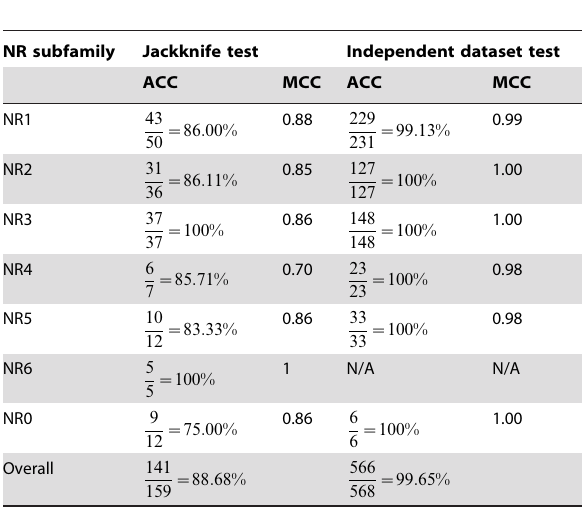
Table 3 . Prediction success rate and MCC index in identifying NR subfamilies by the jackknife test and independent test.